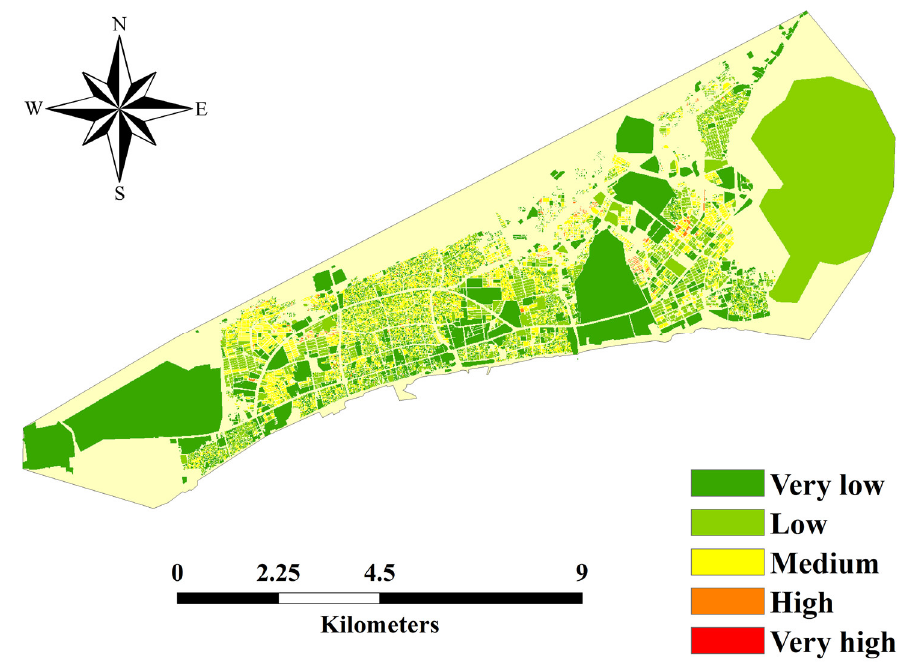
Figure 5. Distribution of population exposure in Bandar Abbas City.